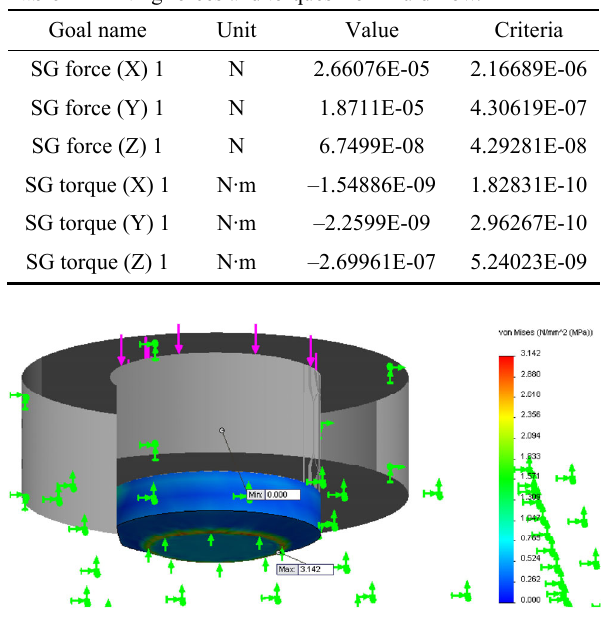
Fig. 5 Stress distribution over contact area (load = 20 lbf and chamfer angle = 20 